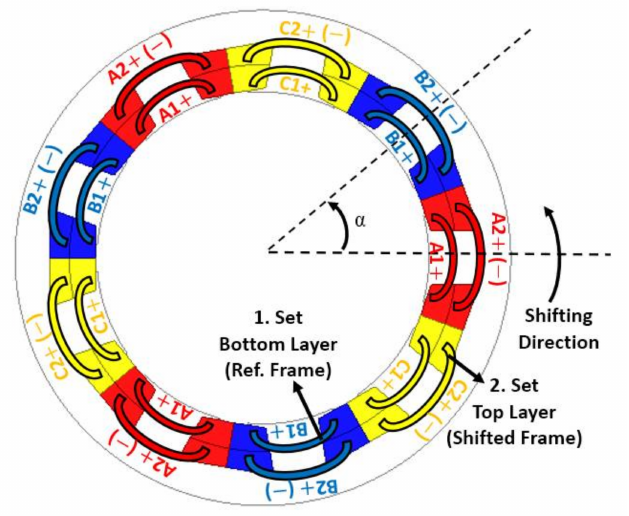
Figure 2. Winding layout of the 9S/6P-4L: ( + ) is the base polarity and ( − ) is the opposite polarity. The new winding factor k wh _ final , which is subjected to the initial winding factor k wh _ initial , the harmonic order h , the shift angle α in ◦ e, and the pole number P , can be calculated by Equation (1). The variation in the low- and high-order winding harmonic factors with α is shown in Figure 3. Since the winding harmonic factors of the 9S/6P combination have only sequential harmonics, whose amplitudes are 0.866, many of the harmonics vary with the same pattern, i.e., the first group 3rd, 15th, 21st and the second group 6th, 12nd, and 24th harmonics have the same pattern. The same phenomenon is valid for the higher-order harmonics. Alternatively, even if the direction of the 2nd winding set becomes negative ( − ), the same waveform shown in Figure 4b is